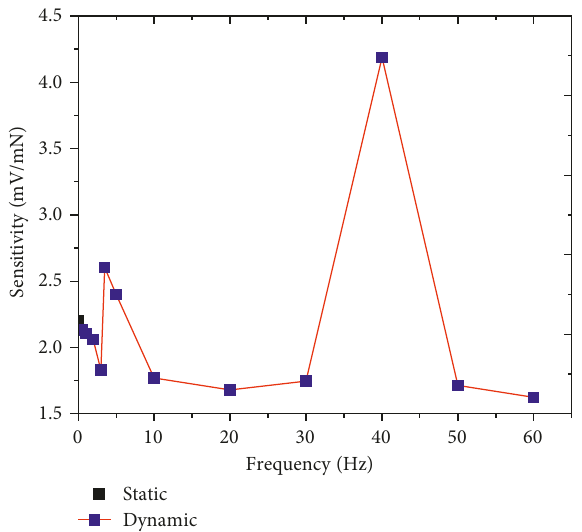
Figure 6: Sensitivity dependence of varying vibration